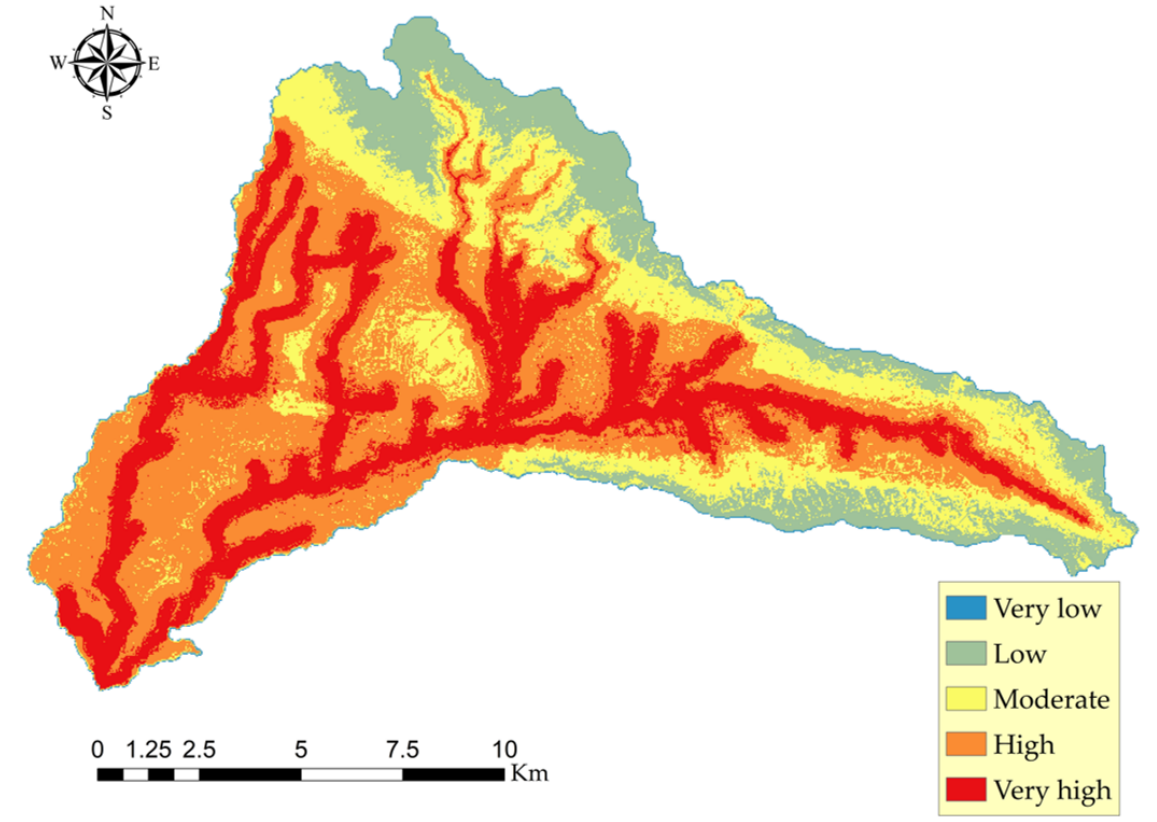
Figure 5. Final flood susceptibility map (FHIS).